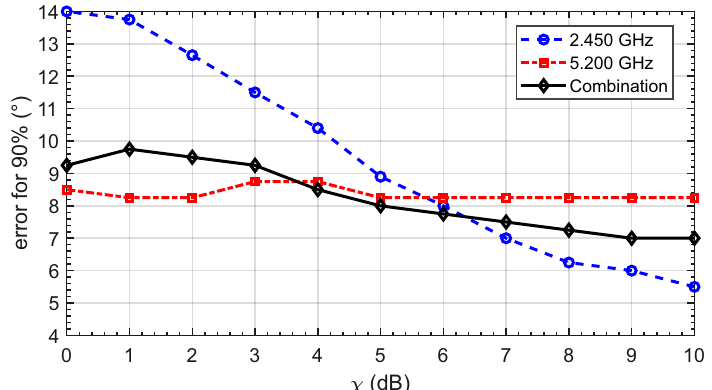
Figure 12. 90-th percentile DoA estimation error for D = 2m.